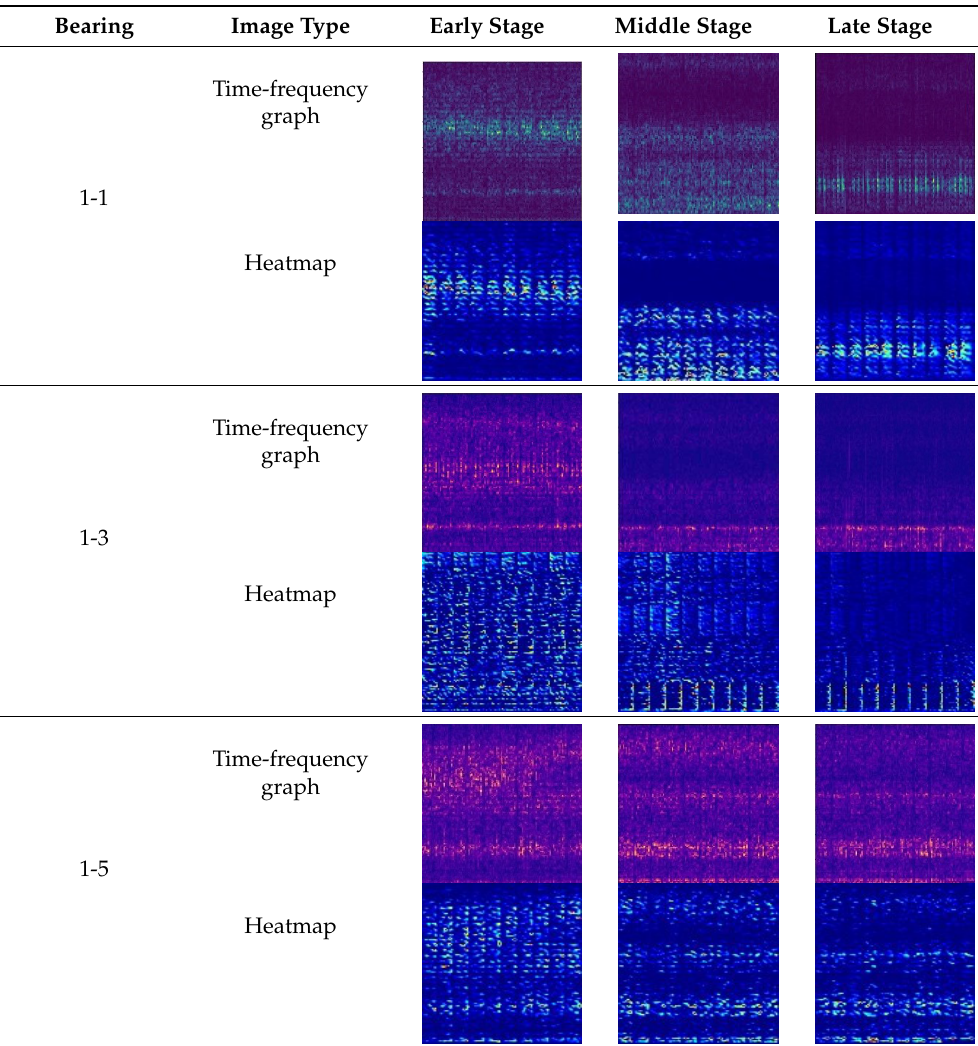
Table 4. Spectrogram and heatmap of bearings in three